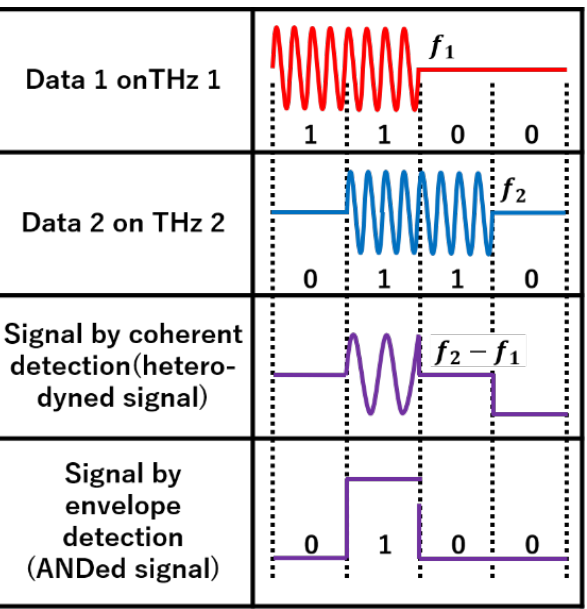
Figure 11. Secured wireless transmission system based on coherent detection between two RF data utilizing beam control.